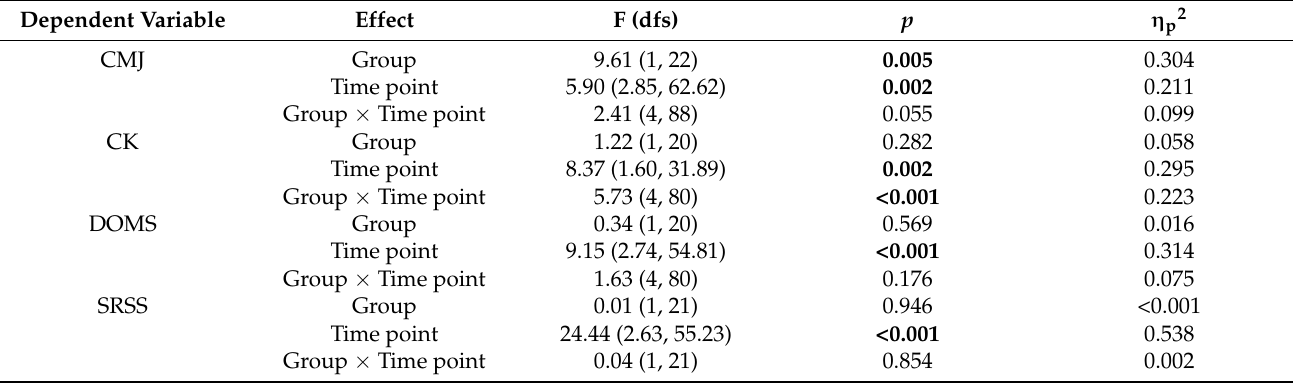
Table 2. Results of ANOVAs and effect size calculations for group, measurement time point (PRE, POST, POST 24 h, POST 48 h, POST 72 h), and interaction effects concerning the test units CMJ, CK, DOMS, and SRSS. Dependent